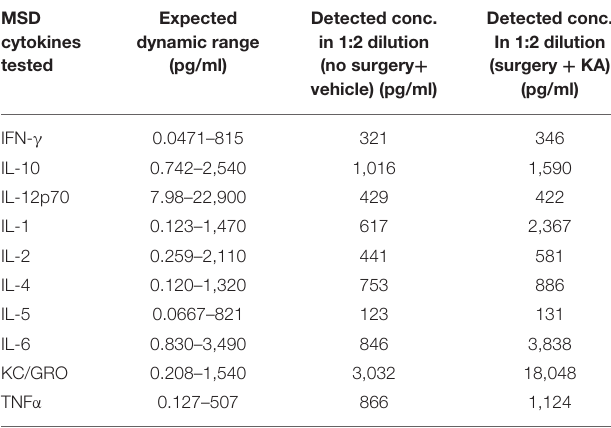
TABLE 5 | The linearity of dilution assessment and detection ranges of cytokines in 1:2 diluted test samples using the MSD assay kit. MSD